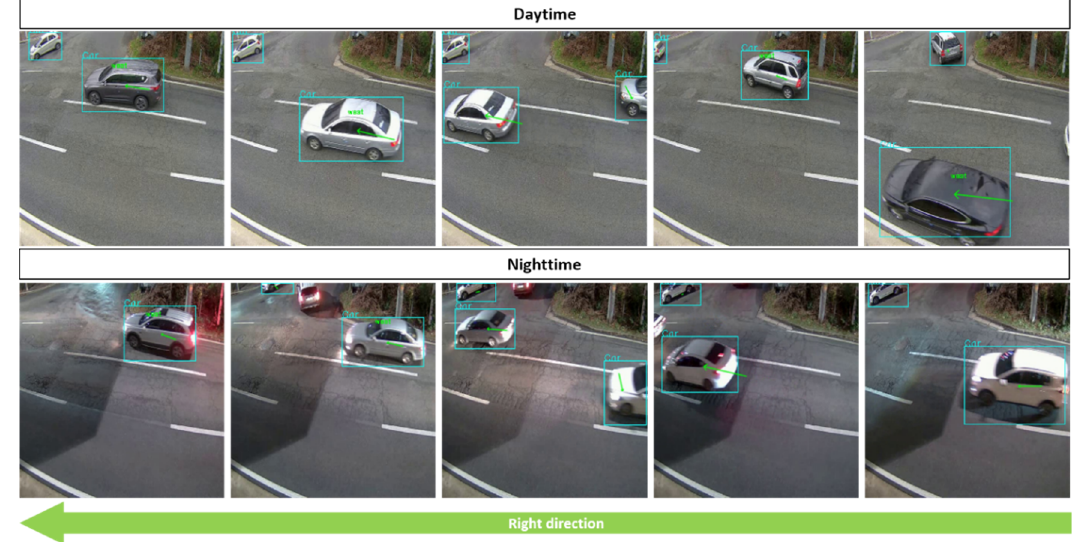
Figure 9. Real-time detection example during both daytime and nighttime.